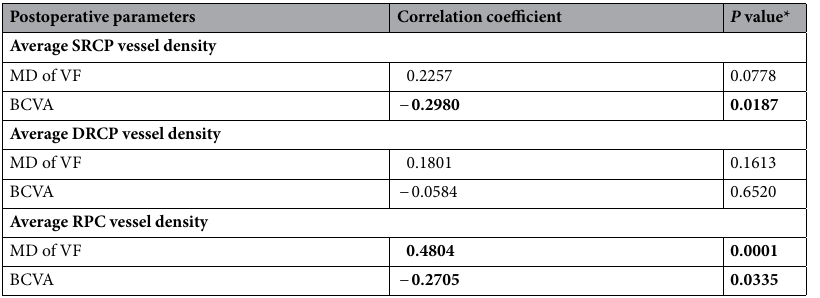
Table 4. Association analysis between postoperative vessel density and functional outcomes. Significant values are indicated in bold. MD mean deviation, VF visual field, BCVA best corrected visual acuity, SRCP